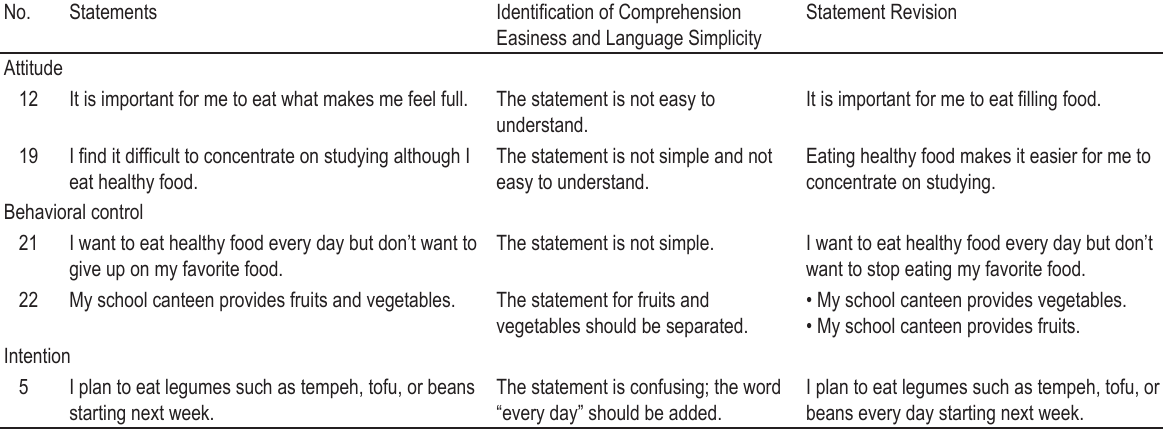
TABLE 3. The revision of statement items of attitude, behavioral control, and intention